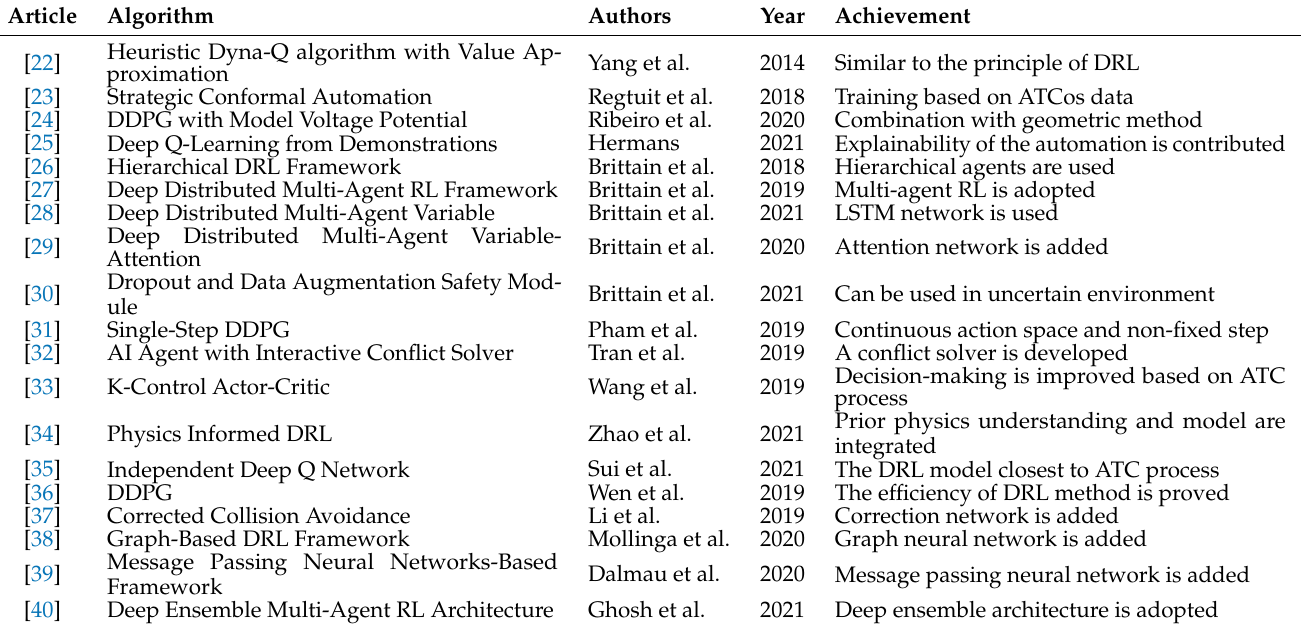
Table 1. Deep reinforcement learning algorithms in conflict